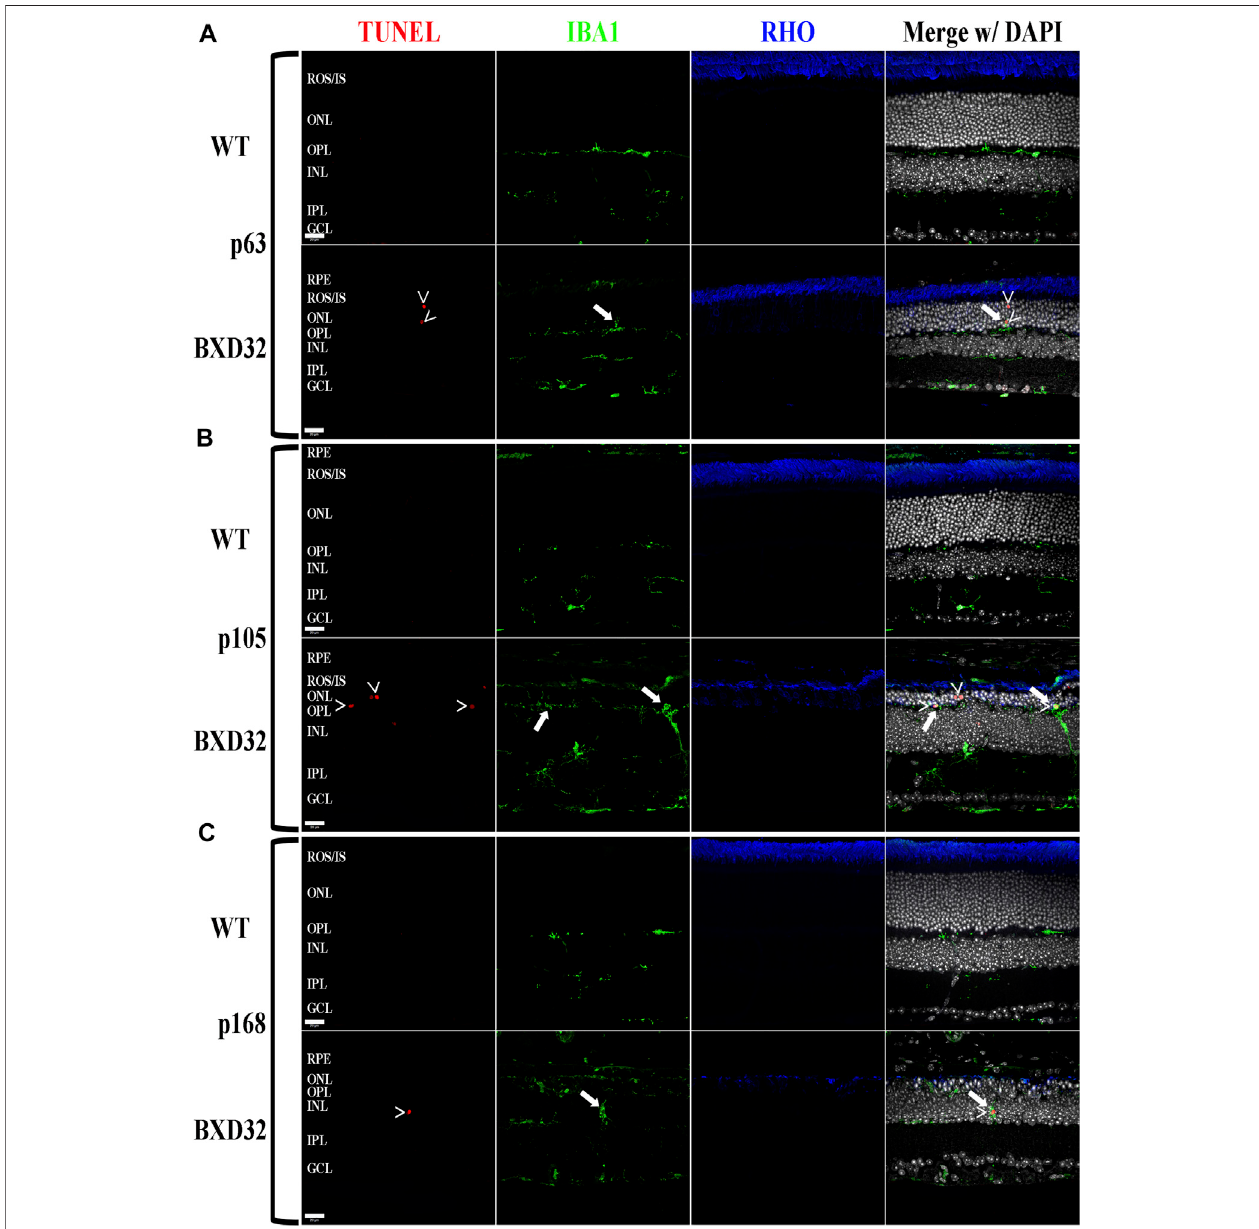
FIGURE5| TheBXD32retinaexhibitscelldeathbyapoptosisandproperfunctionofmicroglia.UsingTUNELlabeling(red)forapoptoticnuclei(arrowheads, > )and immunolabeling for monocytes (IBA1, green) and photoreceptors (RHO, blue) at p63 (A) , p105 (B) and p168 (C) , presumed microglia can be observed migrating to the ONL and phagocytosing apoptotic photoreceptor nuclei (arrows) the normal function of microglial cells in the retina under degenerative conditions. Nuclei stained with DAPI (white/grey). RPE, retinal pigment epithelium; ROS/IS, rod outer segments/inner segments; ONL, outer nuclear layer; OPL, outer plexiform layer; INL, inner nuclear layer; IPL, inner plexiform layer; GCL, ganglion cell layer. Scale bars = 20 μ